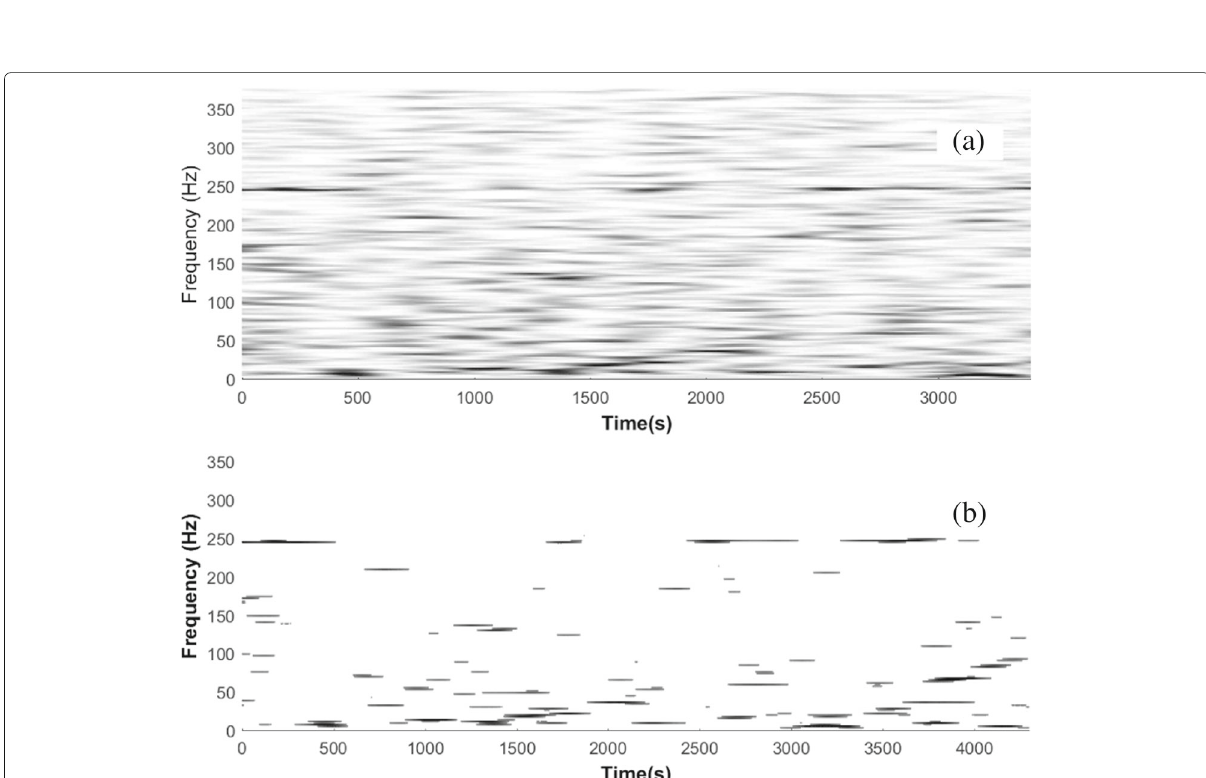
Fig. 10 a Simulated faulty electrode spectrogram and b spectrogram after applied K-means